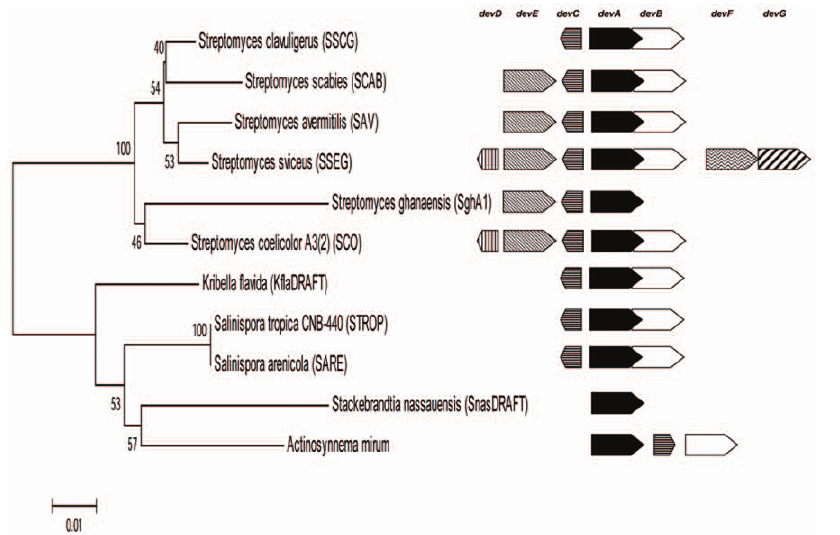
doi:10.1371/journal.pone.0025049.g004